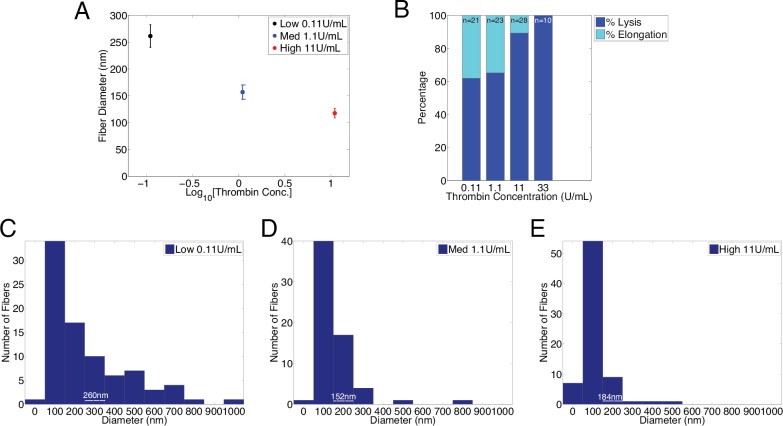
Diameter Dependence of Fibrinolysis.
A Over two hundred single fibers were imaged on the SEM. Fiber diameters were measured at the thinnest point. Data were collected from fibers polymerized at three distinct thrombin concentrations: 0.11 U/mL (84 samples), 1.1 U/mL (64 samples), and 11 U/mL (73 samples), (p < 0.02 for all cases). B Percentage of fibers that lysed or elongated during the first thirty minutes of exposure to 3.3 U/mL of plasmin. Fibrin fibers polymerized by higher concentrations of thrombin lysed more frequently than those polymerized by lower thrombin concentrations. C–E The data in the histograms were segregated according to the percentage of fibers that lysed or elongated. The percentage of fibers with thicknesses below the d
0 diameters (indicated by a white dotted line) parallels the percentage of fibers that lysed in the corresponding bar graphs. The threshold diameter (d0) was 200 nm ± 30 nm.